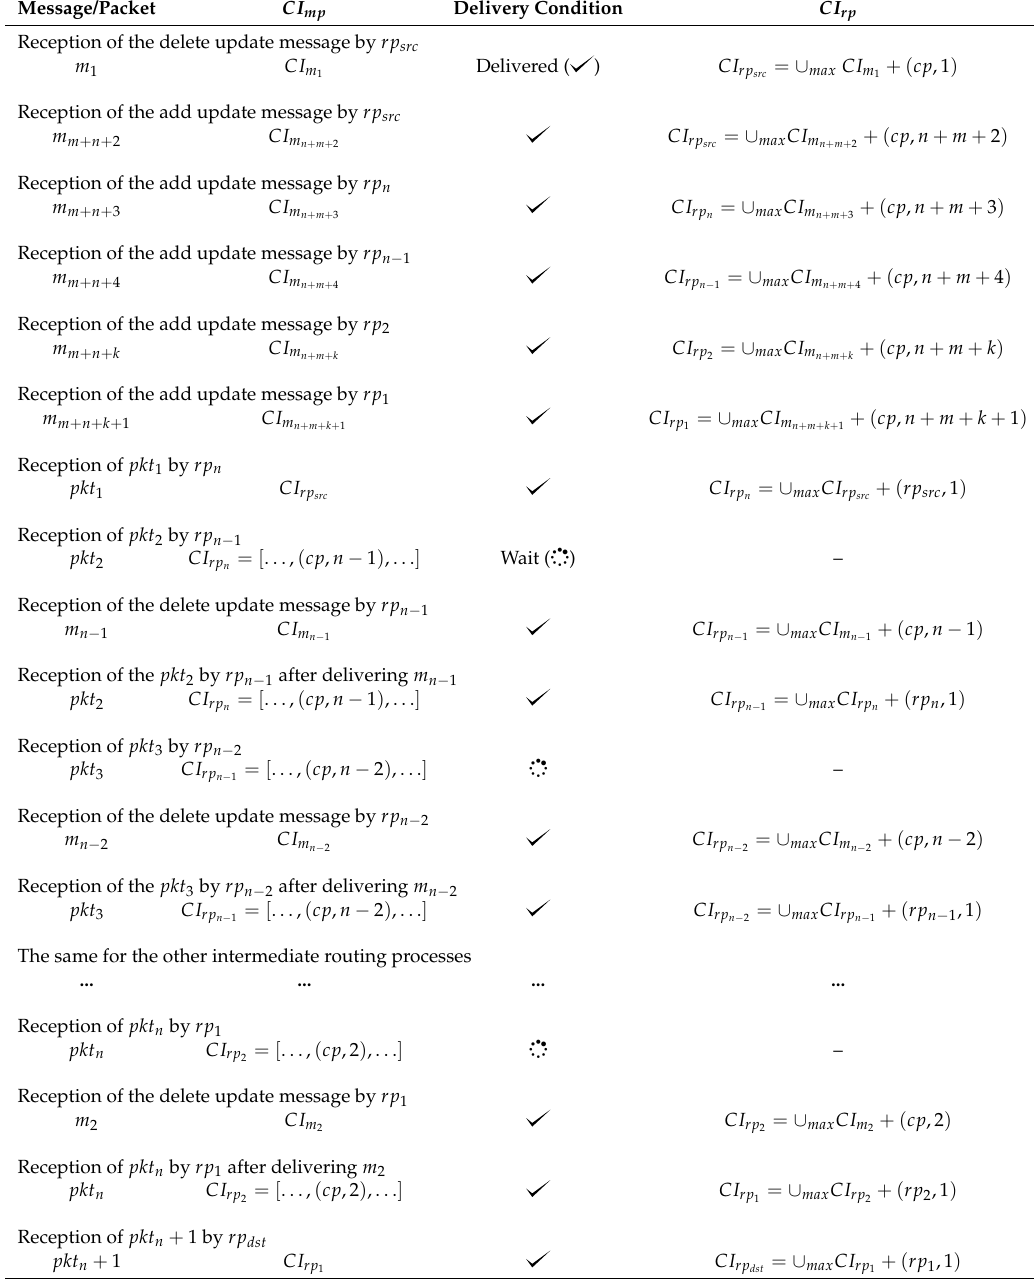
Table 3. Delivery of update messages and data packets mp ∈ MP corresponding to match 1